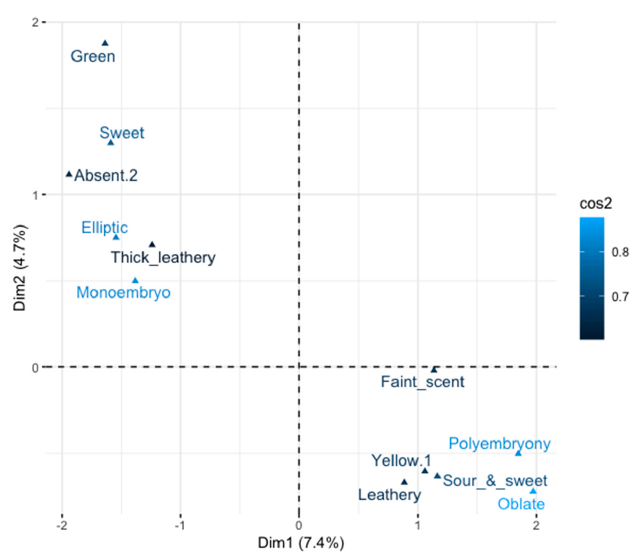
Figure 7. Biplot of qualitative variables significantly represented on the principal components 1 and 2.